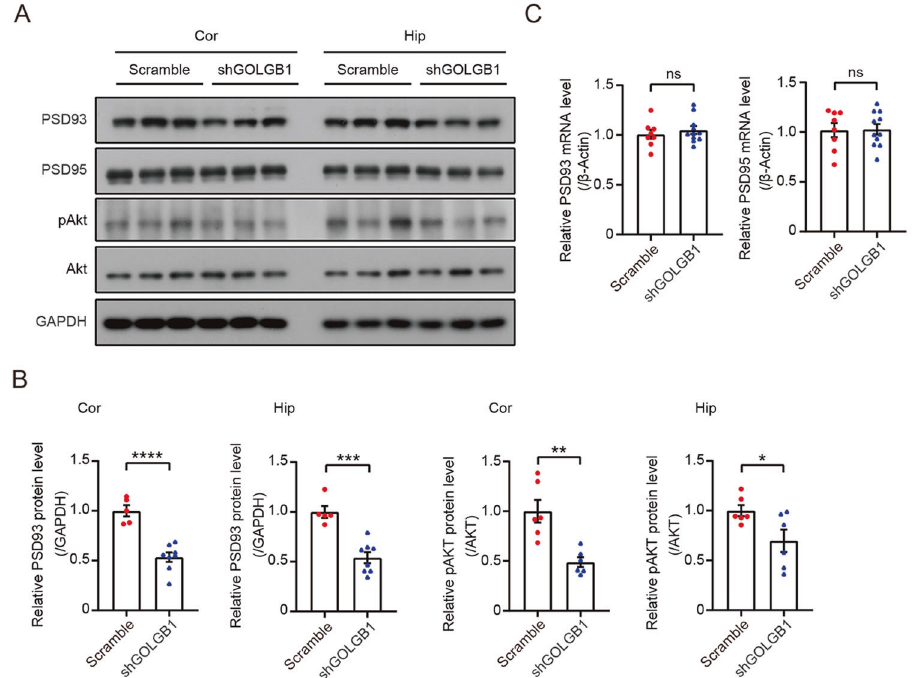
Fig. 5 Downregulation of Golgb1 reduces PSD93 protein levels and Akt phosphorylation. A , B Cortical (Cor) and hippocampal (Hip) tissues from mice injected with AAVs expressing shGOLGB1 or a scrambled control shRNA were collected. Equal amounts of protein lysates were subjected to western blot to study indicated proteins ( A ). Protein levels of PSD93 were quanti fi ed and normalized to those of GAPDH for comparison. n = 8 for shGOLGB1 mice, n = 5 for scrambled control mice. Protein levels of phosphorylated Akt (pAkt) were quanti fi ed and normalized to those of Akt for comparison. n = 6 for each group ( B ). * p < 0.05, ** p < 0.01, *** p < 0.001, **** p < 0.0001; two-tailed Student ’ s t - test. C RNAs were extracted from cortical and hippocampal tissues of treated mice. The mRNA levels of PSD93 and PSD95 were determined by qRT-PCR and normalized to those of β -actin for comparison. n = 11 for shGOLGB1 mice, n = 8 for scrambled control mice. ns: not signi fi cant, two-tailed Student ’ s t